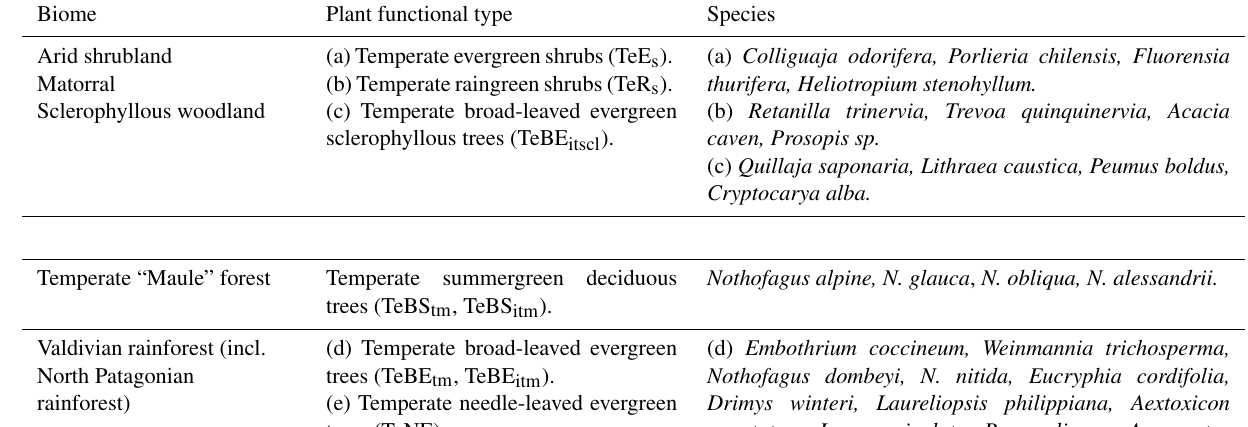
Table 1. Major vegetation zones, associated plant functional types (PFT), and representative species (modified after Escobar Avaria, 2013; Luebert and Pliscoff, 2017; the letters a–e are given to help the reader identify the PFT and the representative